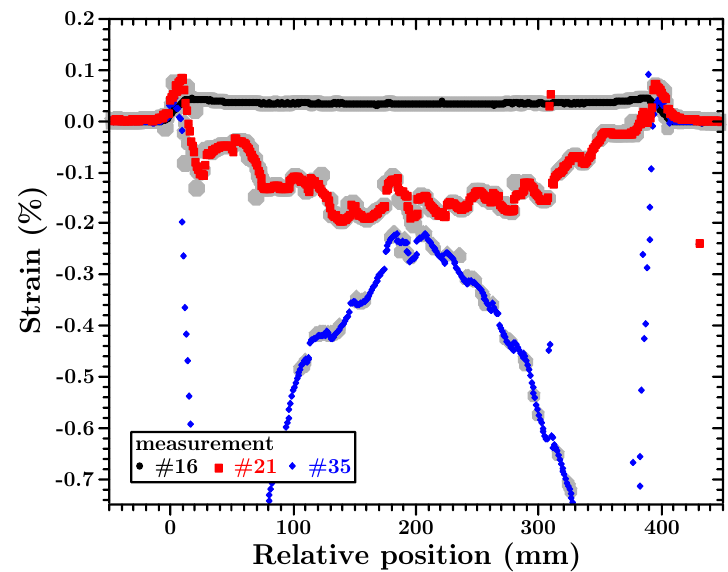
Figure 3. In color: added up strain differences between two subsequent measurements, obtained by the running reference method, yield the absolute strain (cf. the text). Grey points: same data as shown in Figure 2 with the exception of the noise. Data points having the same shape belong to the same measurement (cf. the text). Measurement times: #16 → 200min, #21 → 226min, #34 → 267min.